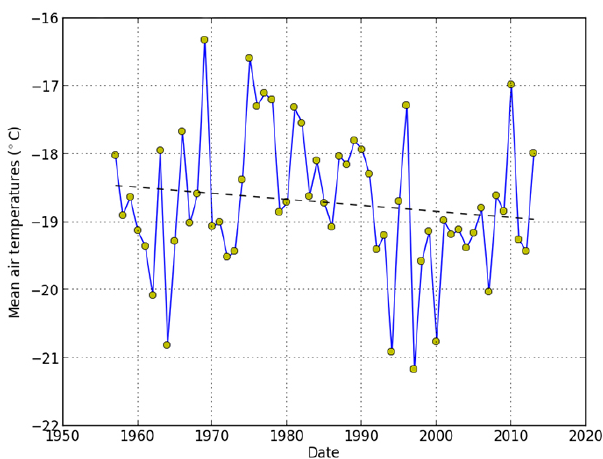
Fig. 3. Annual surface air temperatures at the Halley Research Sta-